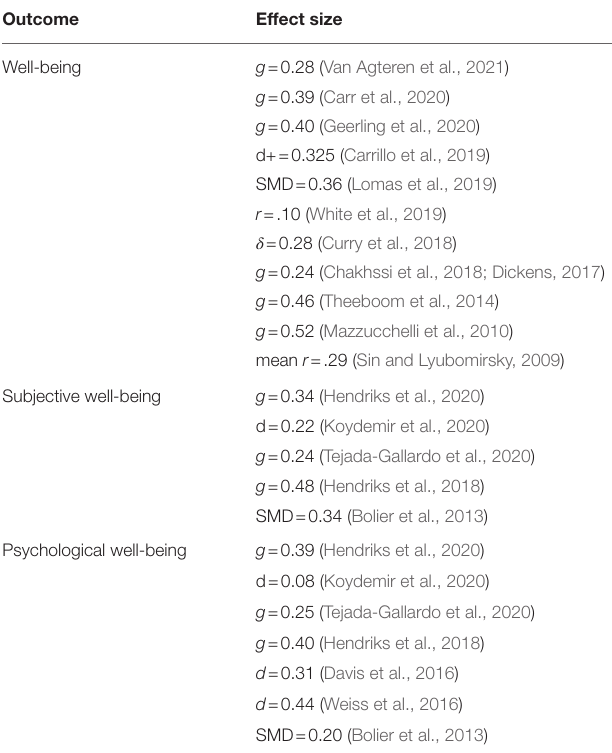
TABLE 2 | Small to moderate well-being effect sizes in positive psychology intervention meta-analyses.